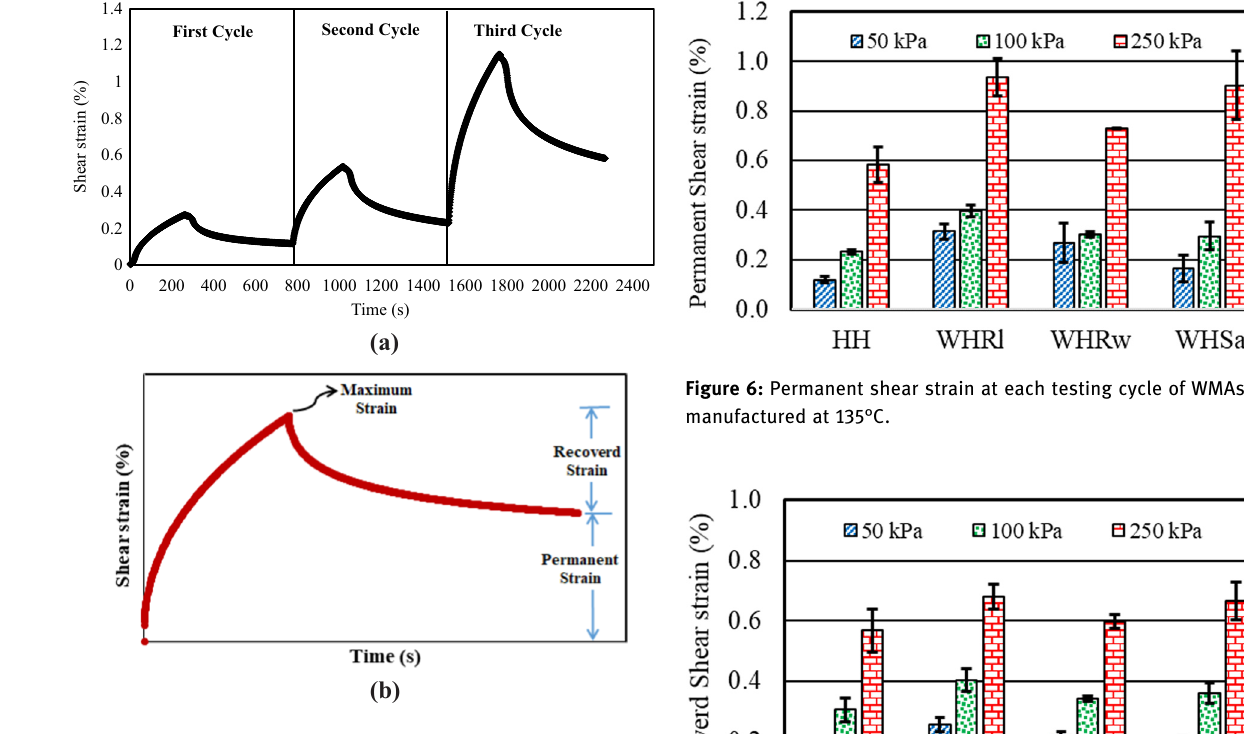
Figure 4: Typical curve of an MSCR result. ( a ) Three cycles. ( b ) Typical one cycle.